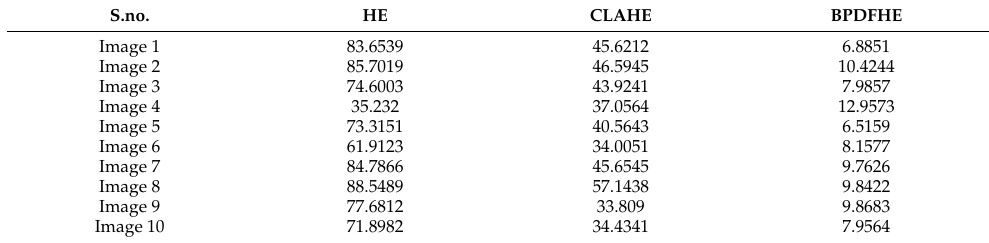
Table 3. Comparison of RMSE